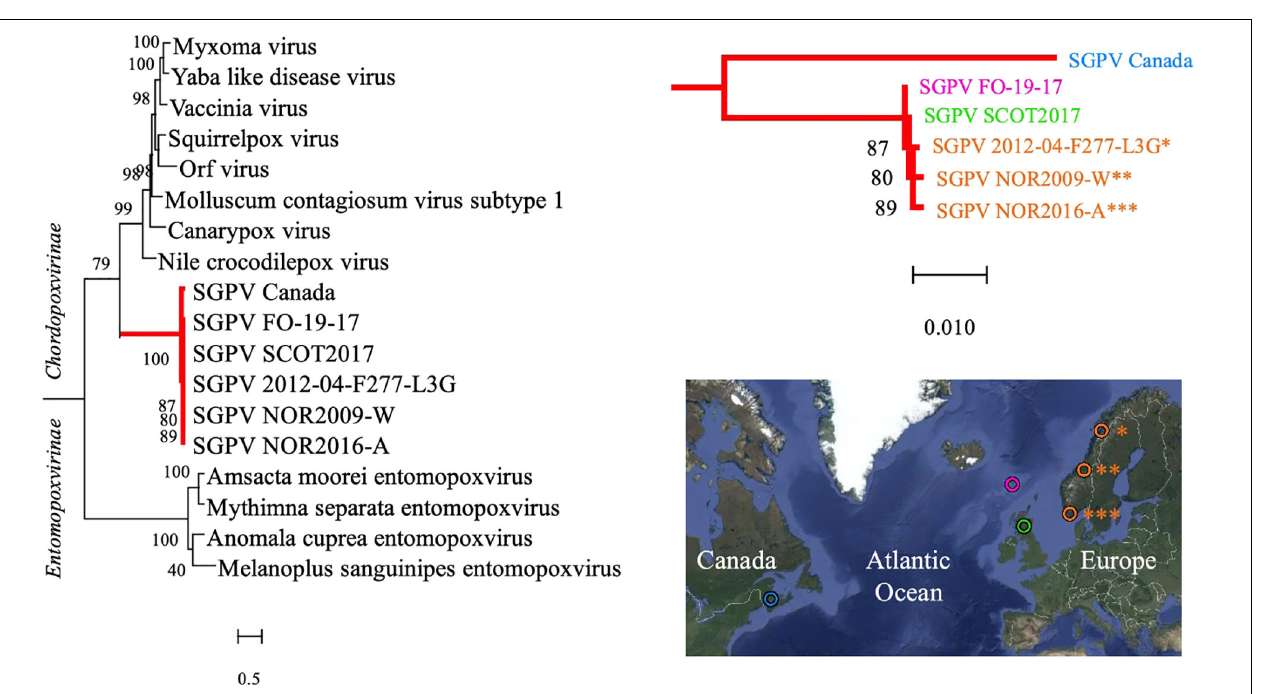
FIGURE 2 | A Maximum Likelihood tree based on the concatenated amino acid sequences encoded by two genes (major capsid protein and DNA-directed RNA polymerase subunit beta) in various members of the Poxviridae family is shown on the left. The SGPV branch is further colored red and magnified on the upper right, illuminating its clear bifurcation into two distinct sub-lineages, respectively, comprising SGPV strains from Northeast America (Canada/blue) and Europe (Faroe Islands/pink, Scotland/green and Norway/orange), as shown in the map on the lower right. Sequences from the African swine fever virus (hidden) were included for tree rooting, and the aLRT SH-like method was employed for estimating branch support values. See Supplementary Figure S4 for trees based on individual alignment of the two genes and GenBank accession numbers. Map created with Google Maps (Map data/imagery: INEGI, Nasa,